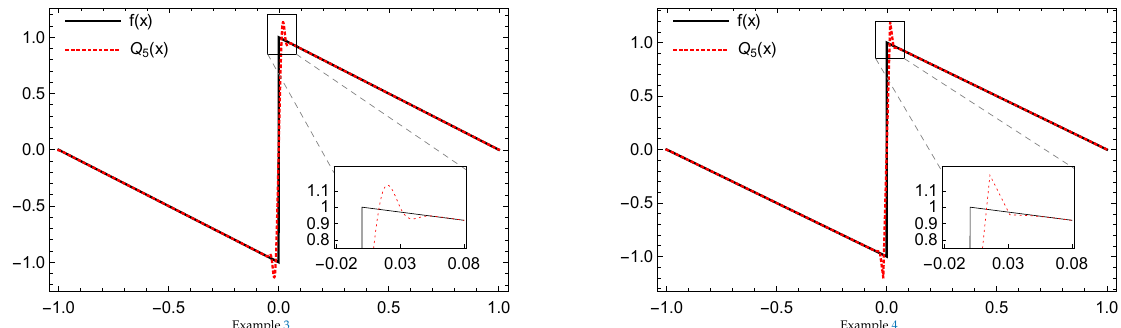
Figure 14. Gibbs effect illustrations by Q 5 f ( x ) of Example 3 and 4,